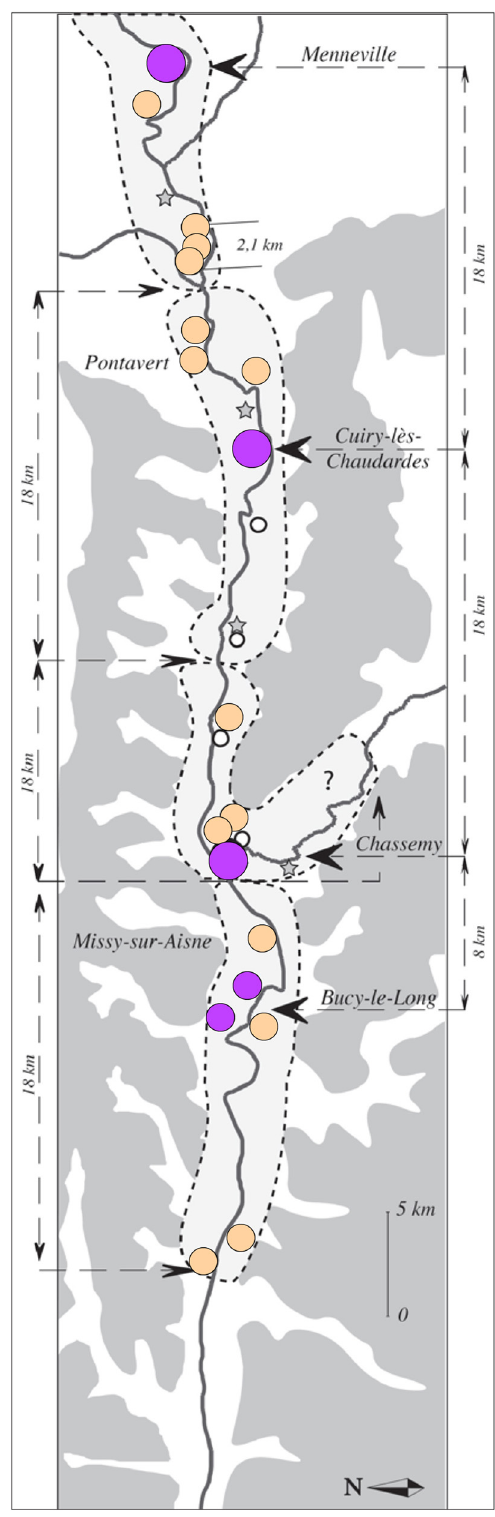
Figure 6: Distribution of main and secondary LBK sites in the Aisne valley. Purple dots: main sites; yellow dots: secondary sites; and white dots: other sites ( after Dubouloz, 2012b, Figure 6; et Ilett & Plateaux, 1995, Figure 6 )